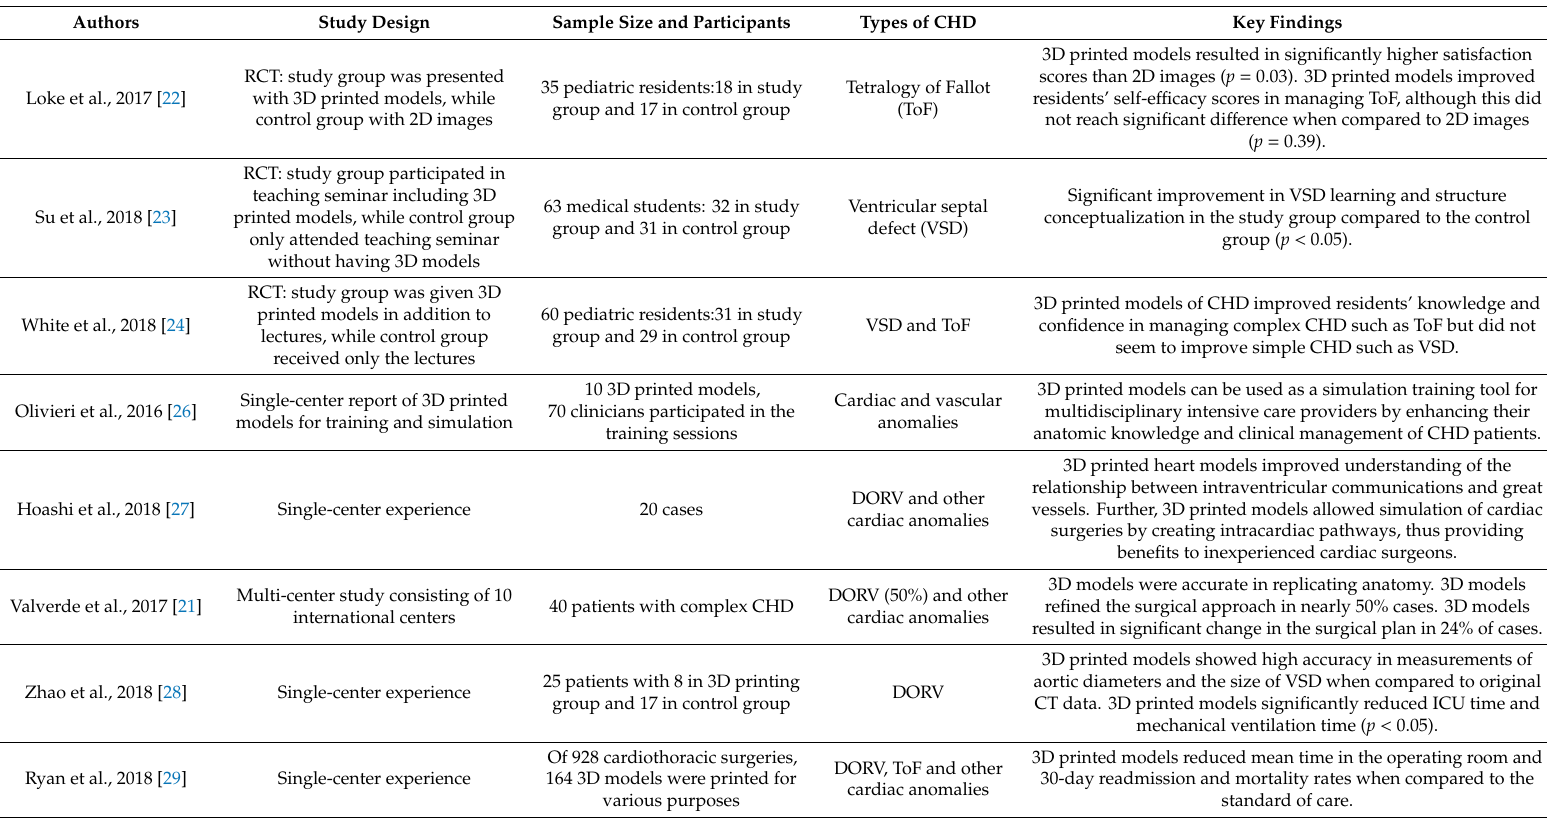
Table 1. Study characteristics of randomized controlled trials and multi- and single-center